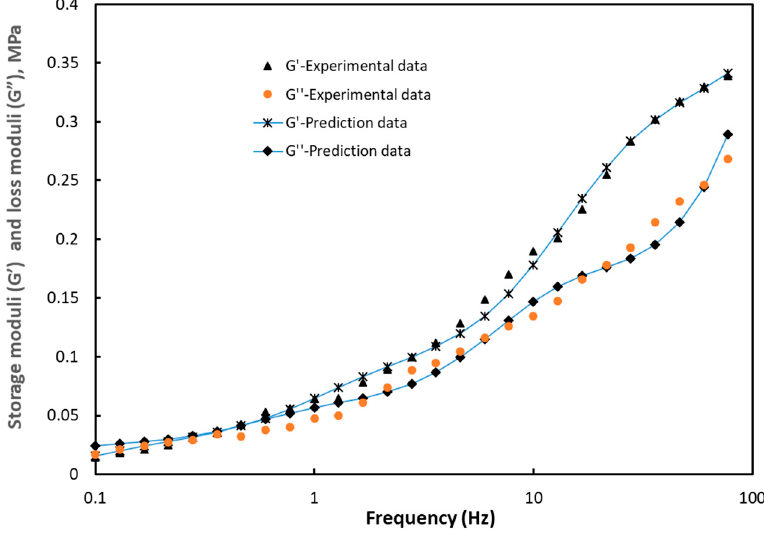
Figure 7. Results of the optimization with the experimental storage moduli G’ and loss moduli G”.